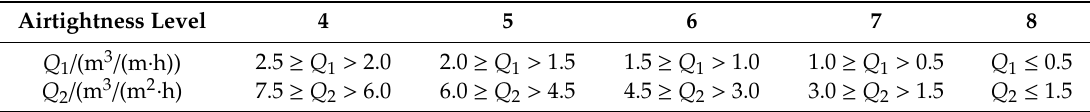
Table 4. Air permeability performance classification of external window.